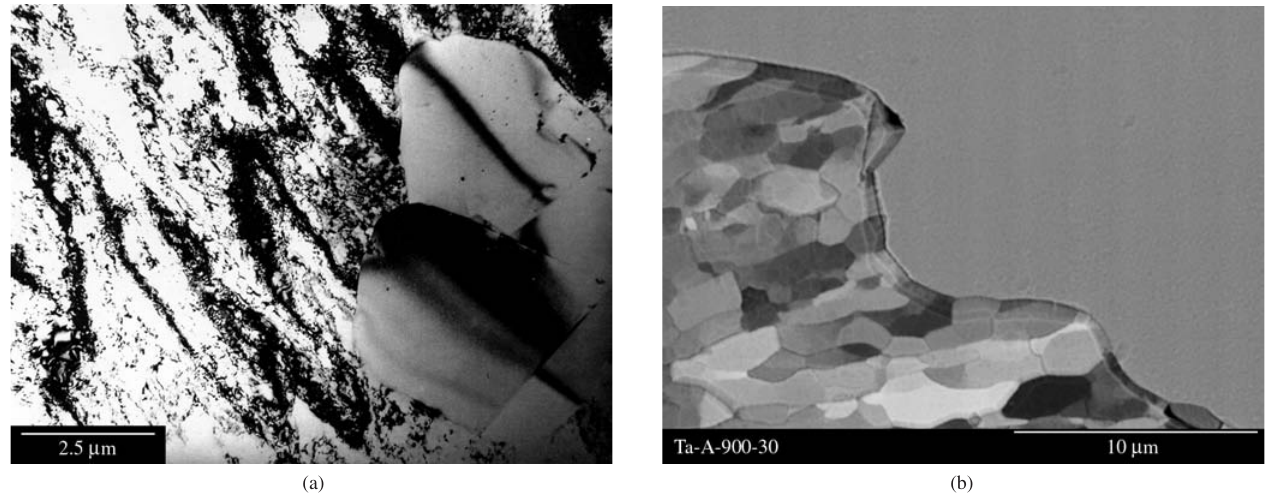
Figure 7. Reaction fronts (high angle boundaries) migrating during recrystallization: a) transmission electron micrograph of an austenitic stainless steel contain- ing 15% Cr and 15% Ni, cold worked to a 50% area reduction and annealed at 800 °C for 3 hours (by kindness of K. Ehrlich, Forschungszentrum Karlsruhe, FZK, Germany); and b) micrograph of a sample of pure tantalum cold worked to 72% area reduction and annealed at 900 °C for 30 minutes (SEM,